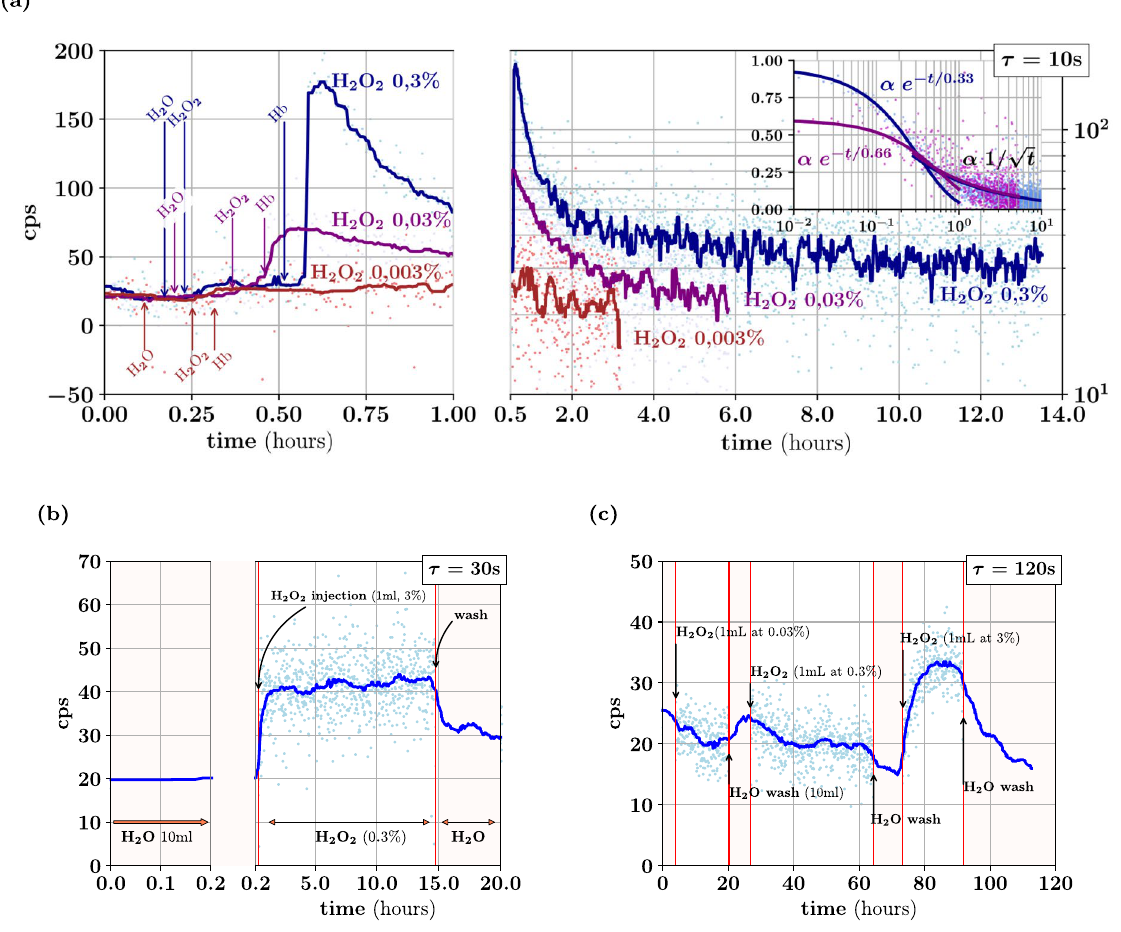
Figure 3. Luminescence from non-catalytic disproportionation of H 2 O 2 . Luminescence of H 2 O 2 in water, with or without catalyst. ( a ) Shows the count rate (counts per second, cps) measured on the detector for a τ = 10 s exposure time along 3 different procedures (bleu, cyan, and red) in which 1 mL of H 2 O 2 is injected in 10 mL of water, followed by 1 mL of hemoglobin (0.5 mg mL −1 ), to reach a final concentration of 0.3% , 0.03% , or 0.003 wt% respectively. Two subplots of the same data are presented to separately show the initial and the long time-scale behavior. Dots represent the value measured for each frame, while lines indicate the moving median value over 7 frames. The insert shows how the data could be fit, initially with an exponential, and with a power law at later times. ( b ) Count rate observed over τ = 30 s in the absence of hemoglobin in 10 mL of pure water upon the injection 1 mL of H 2 O 2 to reach a final 0.03% concentration. After 15 h, the medium is washed away and replaced with the same volume of water. Two adjacents subplots of the same data illustrate the initial and the long time-scale behavior. ( c ) Count rates observed for a τ opt = 120 s exposure time in the absence of hemoglobin in 10 mL of pure water upon the successive injection 1 mL of H 2 O 2 at increasing concentrations, to reach 0.003% , 0.03% and finally 0.3% . The medium is washed away and replaced with the same volume of water between the injections. All experiments were repeated at least twice with each detector and integrating cavities. Typical time traces are